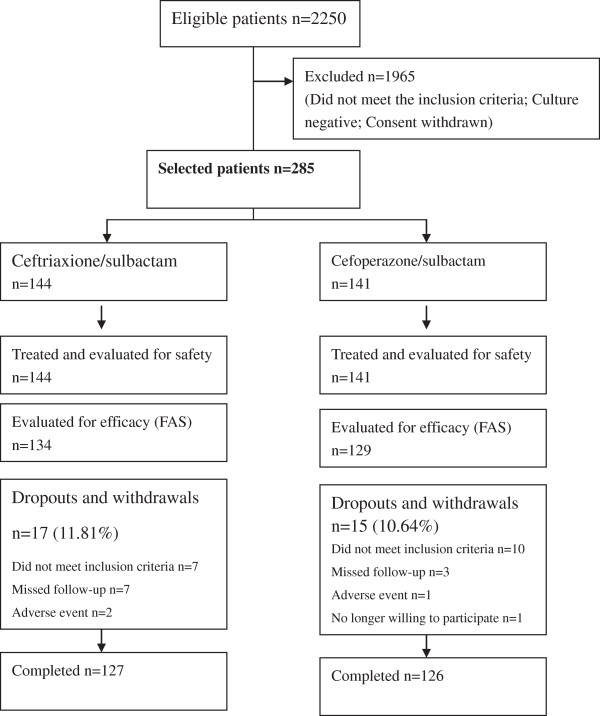
Subject disposition.